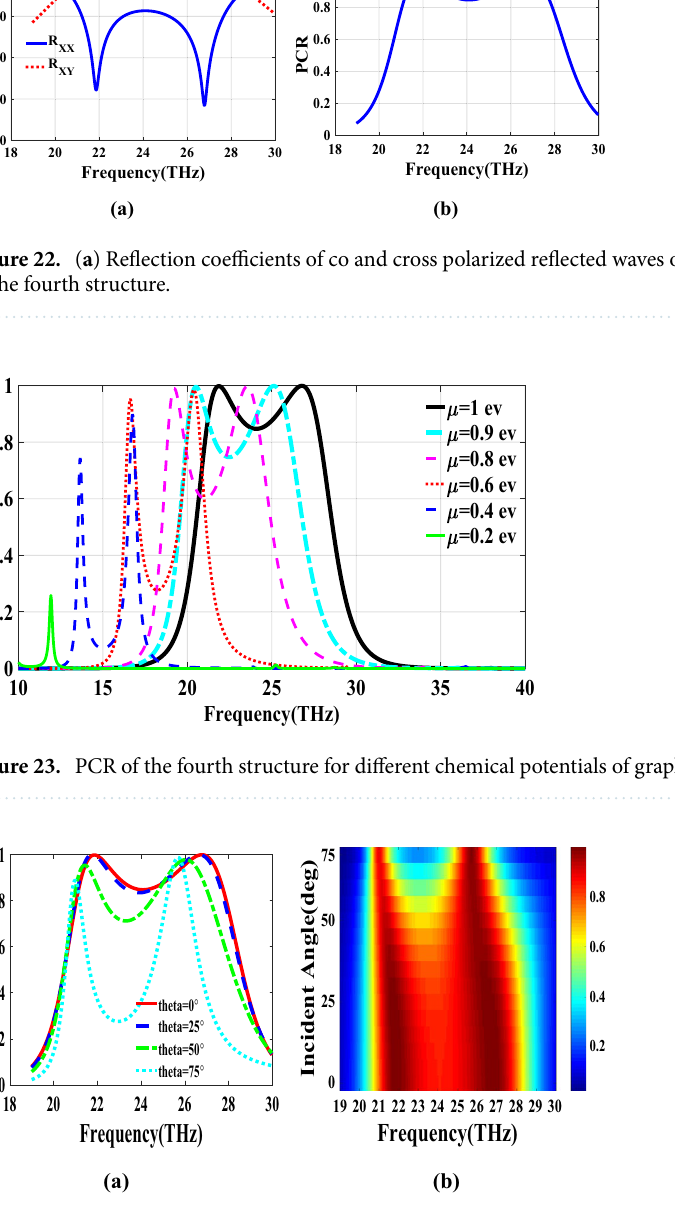
Figure 24. PCR of the fourth structure for different incident